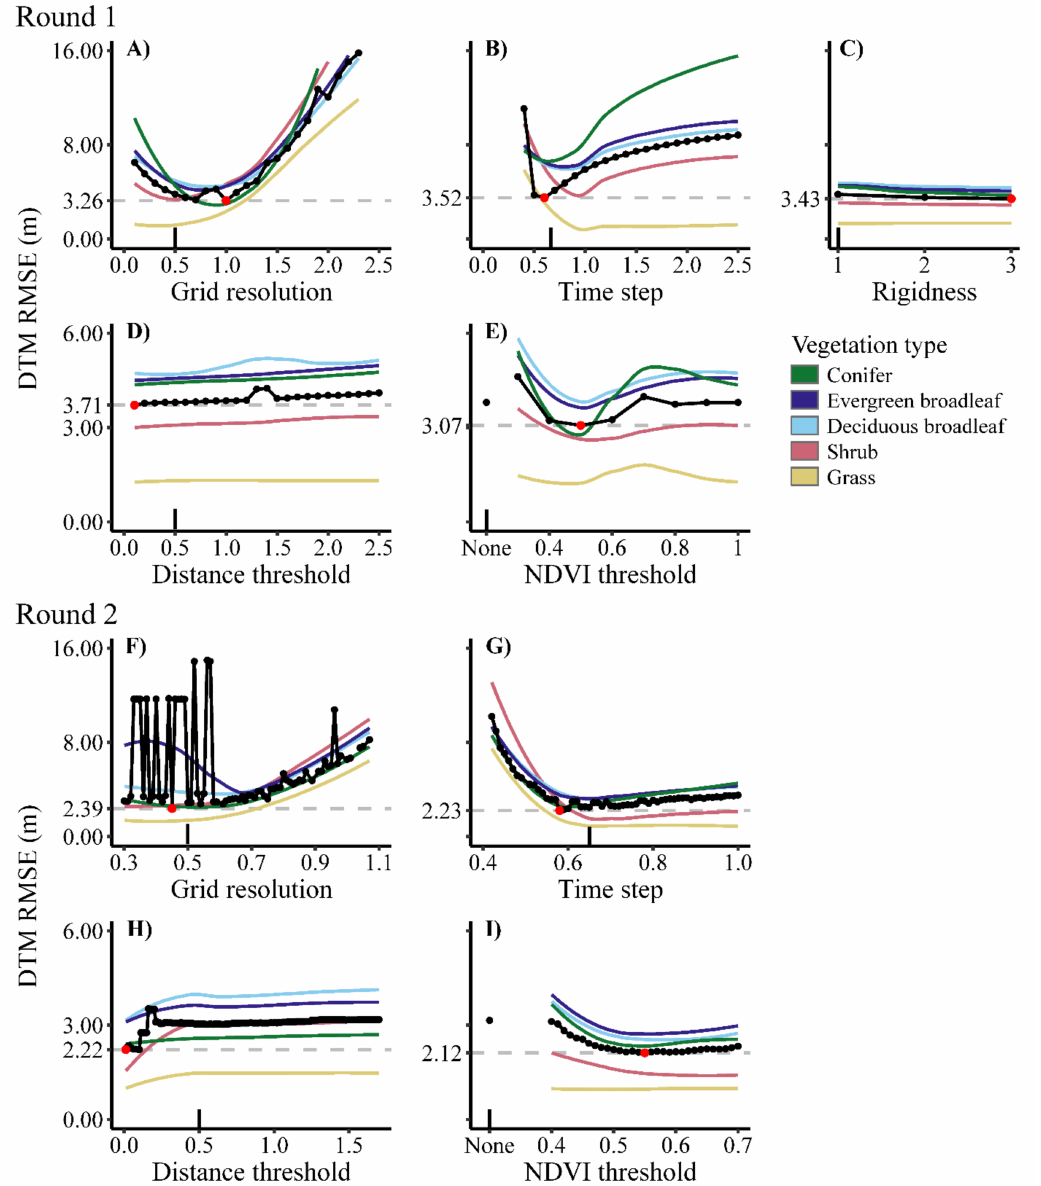
Figure 3. CSF parameter effect on DTM accuracy for Round 1 (top) and Round 2 (bottom) of optimization. The DTM root-mean-square error (RMSE, m) for the entire study site is shown by black points and black line. Colored lines depict RMSE by vegetation type smoothed using local polynomial regression. Red dot and horizontal grey dashed line denote minimum achieved RMSE. Vertical black line intersecting the x-axis indicates default parameter